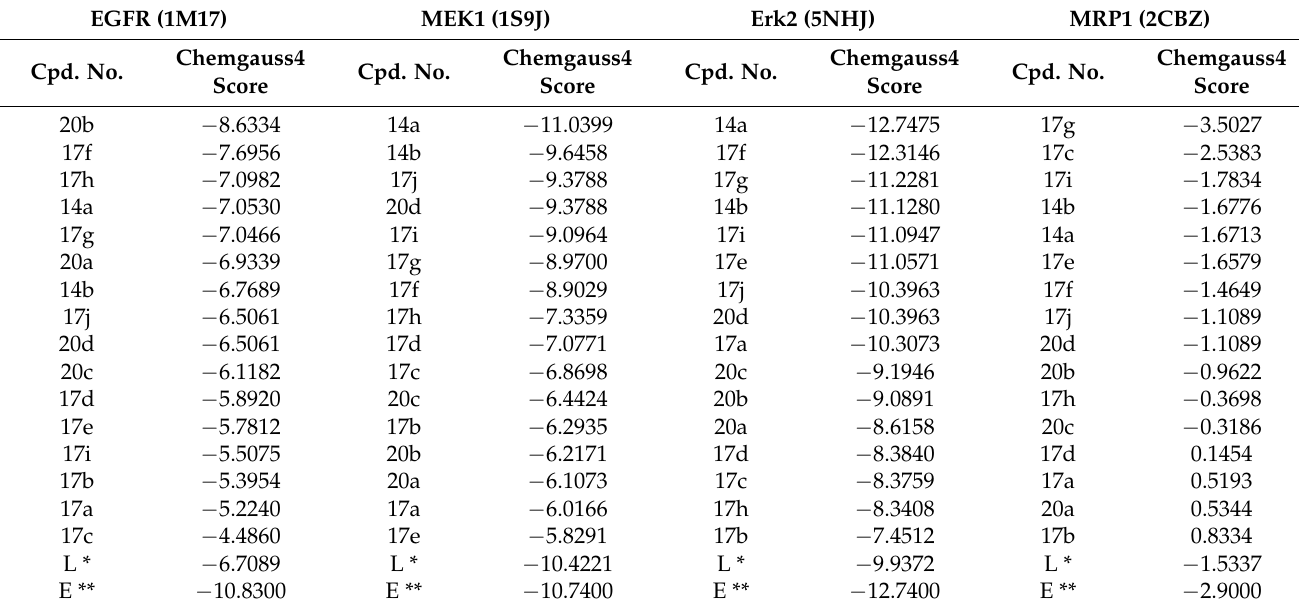
Table 5. FRED Chemgauss4 score for the designed compounds, lead compound NO-CIEA 17 and erlotinib docked with EGFR, MEK1, Erk2, and MRP1 protein active sites.